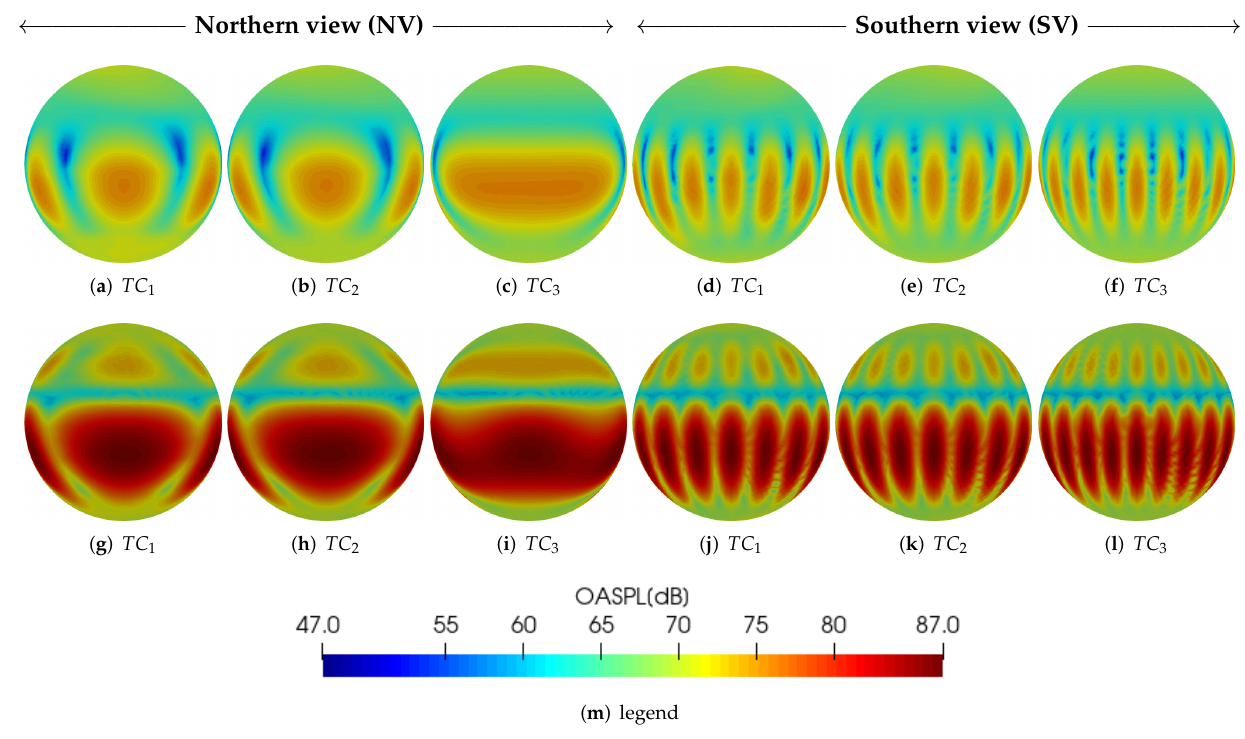
Figure 2. Counter-rotating propellers, influence of TC on OASPL, for M t = 0.52 (upper) and M t = 0.7 (lower).